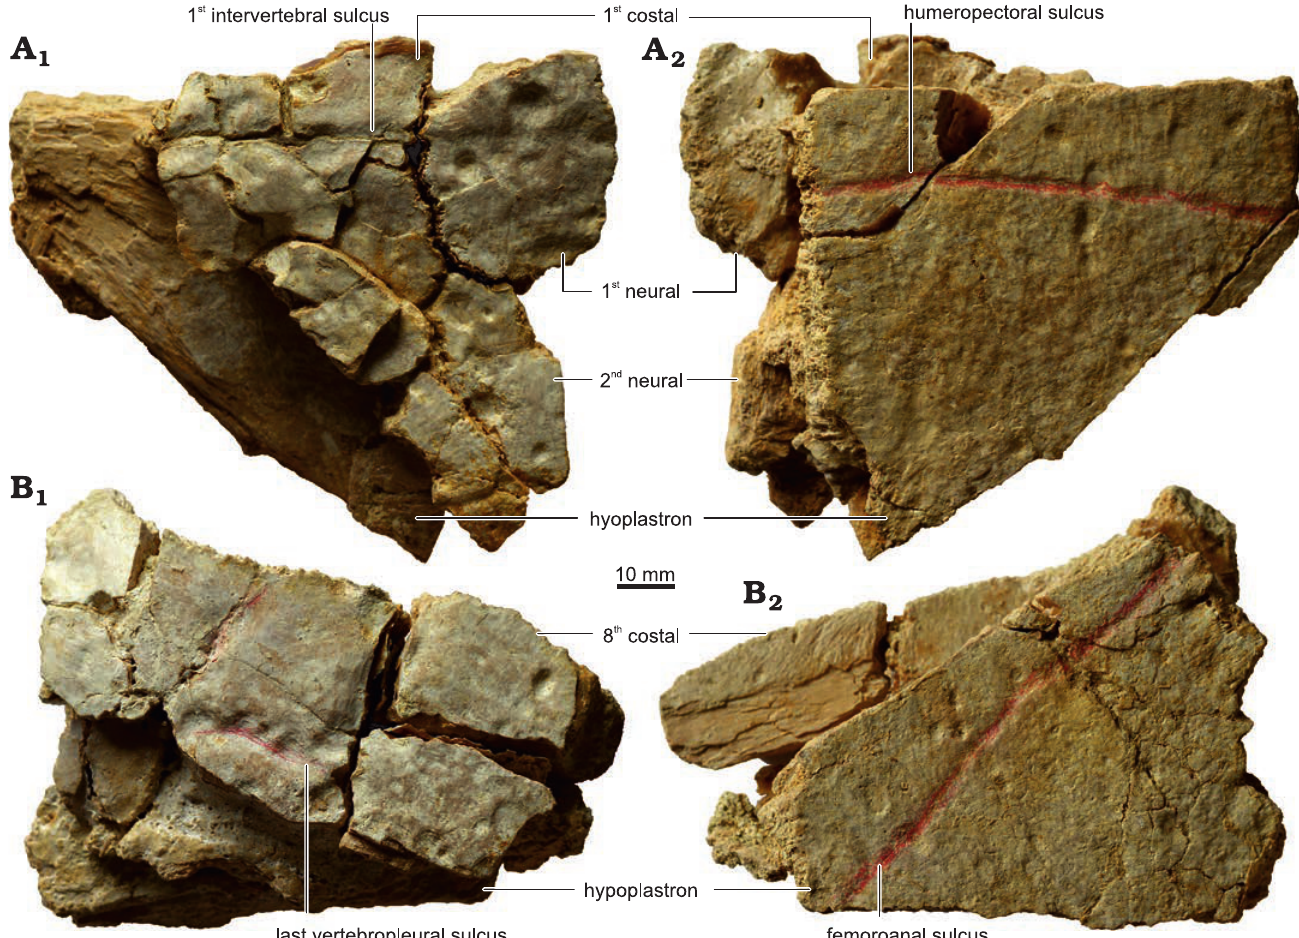
Fig. 3. The thalassochelydian turtle Craspedochelys ? sp., MZ VIII Vr-71, from the Kimmeridgian of Krzyżanowice, parts of the carapace and plastron likely belonging to a single individual. A . Anterior part of the carapace and plastron (Fig. 6A: 2) in dorsal (A 1 ) and ventral (A 2 ) views. B . Posterior part of the cara - pace and plastron (Fig. 6A: 3) in dorsal (B 1 ) and ventral (B 2 ) views. The fragments likely belong to the same individual as the material shown in Fig.